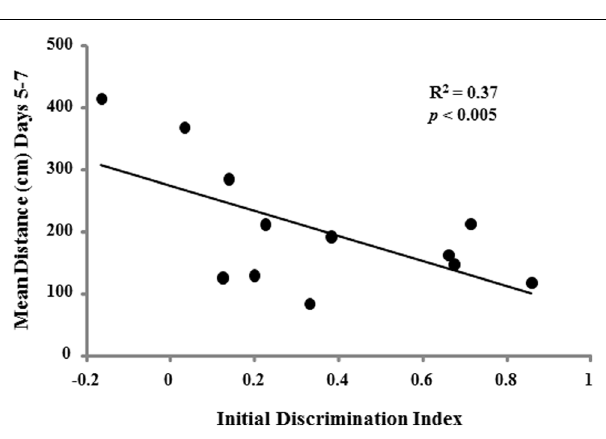
n = 14), middle-age (Mid Age, gray circle, n = 18), and aged (filled circle, n = 12) rats. Note that aged animals exhibit an initial impairment observed as a longer escape path length. (B) Discrimination index measure for a retention probe trial performed 24 h after the final day of reference memory training. Discrimination index values were all significantly different from chance ( p < 0.05) and no age difference was observed for the reference memory.